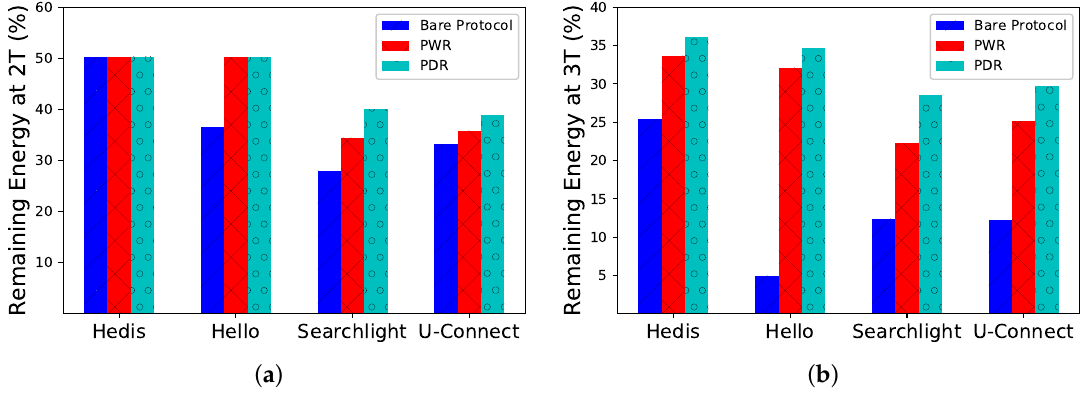
Figure 8. Spear saves more energy by incorporating PWR and PDR compared to bare algorithms. ( a ) After 2 ˆ T ; ( b ) After 3 ˆ T